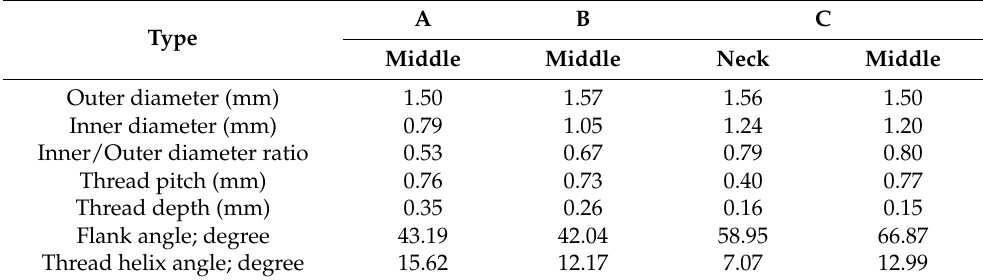
Table 1. The parameters of microimplants.